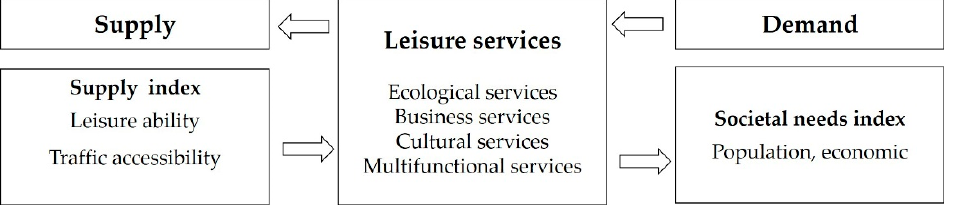
Figure 3. Flowchart of the proposed workflow for mapping the spatial mismatch of urban LSs in Beijing, China.